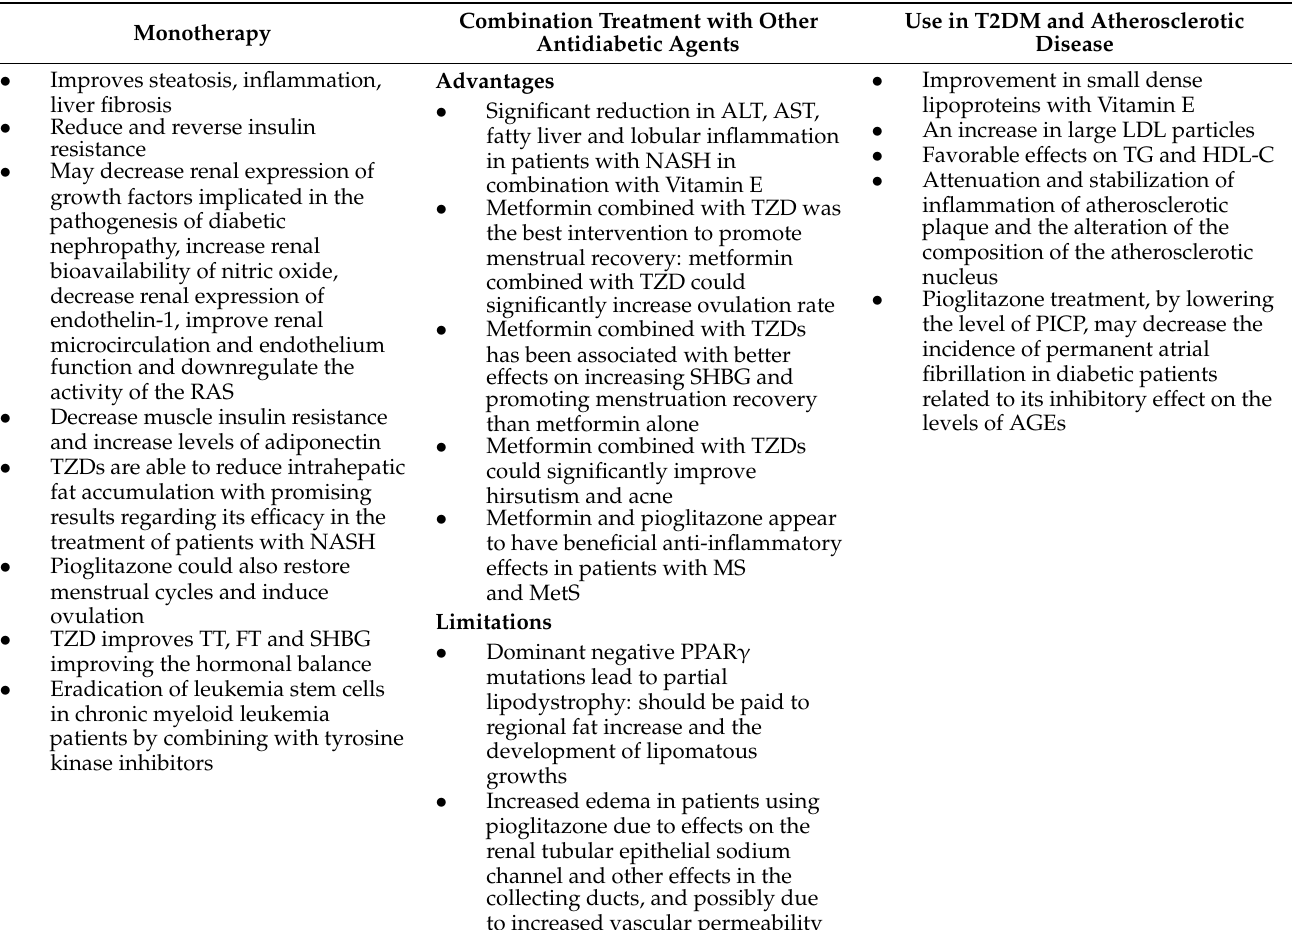
Table 2. Use of the thiazolidinediones in type 2 diabetes and cardiometabolic